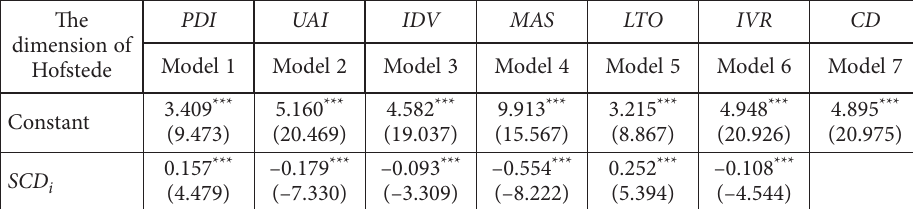
Table 3. The moderating effect of economic growth on Hofstede’s cultural dimensions and IPO under- pricing (source: authors’ calculation) The dimension of